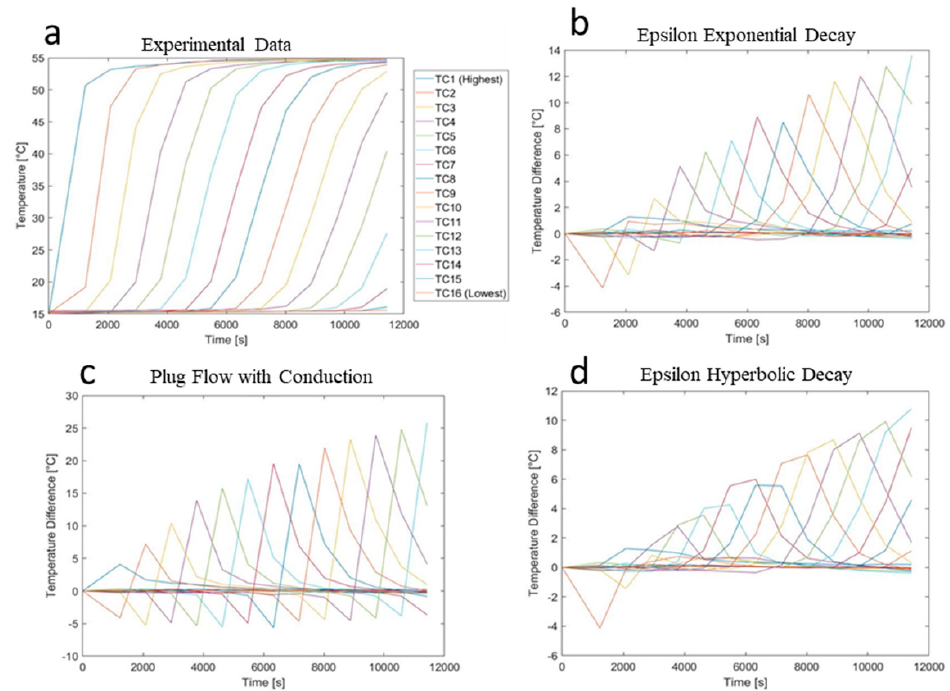
Figure 5. Experimental data for the source heating experiment (0.23 GPM) temperature difference of the experimental data subtracted from the model. ( a ) Experimental data; ( b ) ε model using exponential decay; ( c ) plug-flow model with the inclusion of conduction in the water; and ( d ) ε model using hyperbolic decay.